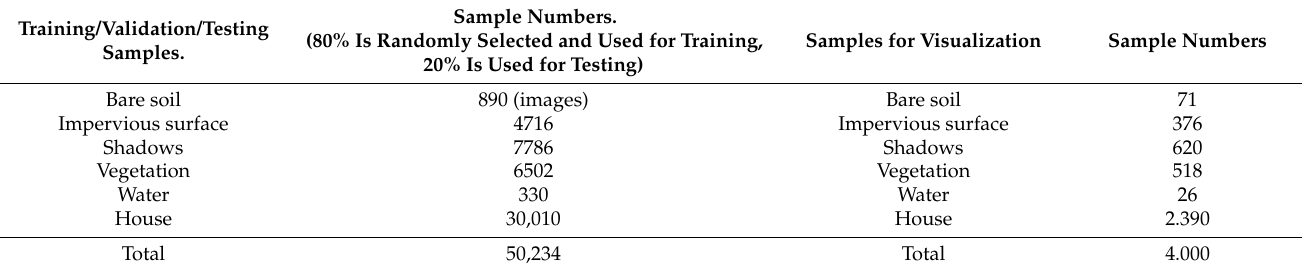
Table 3. Samples for training, validation, testing the proposed model, and samples for visualization. Training/Validation/Testing